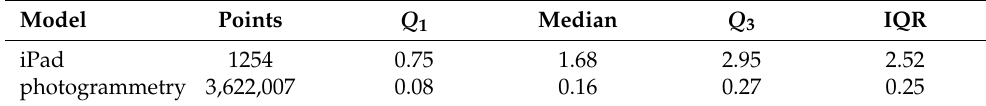
Figure 6. Comparison of statistical values for fine detail. Photogrammetry: ( a ) textured mesh, ( b ) point cloud, ( c ) histogram of distances to the model; iPad: ( d ) mesh, ( e ) point cloud, ( f ) histogram of distances to the model. Point clouds are coloured according to histogram data. Table 1. Comparison of statistical values for fine detail [mm].